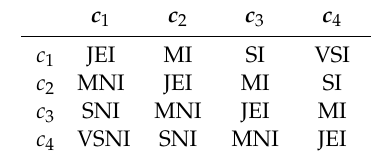
Table 3. Linguistic term based paired comparison results on criteria c 1 , c 2 , c 3 , and c 4 . c